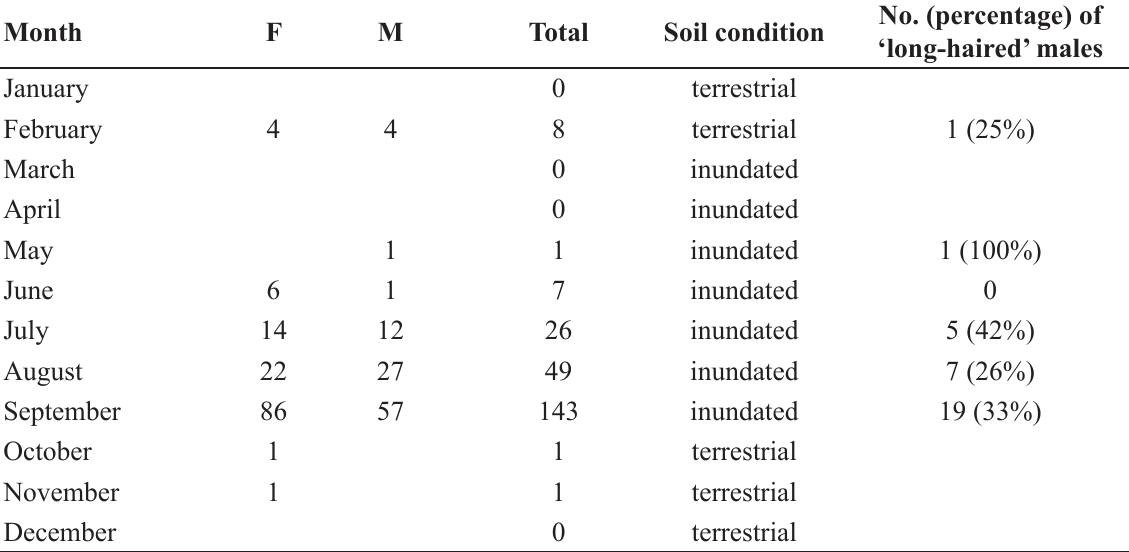
Table 2. Numbers of S. setaepromissa sp. nov. found at different times of the year, with information about the soil conditions at the time of